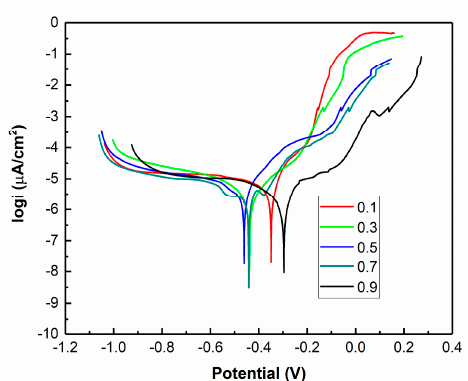
Figure 10. Polarization curves of Ni–Co–BN (h) nanocomposite coatings with varying duty cycles.